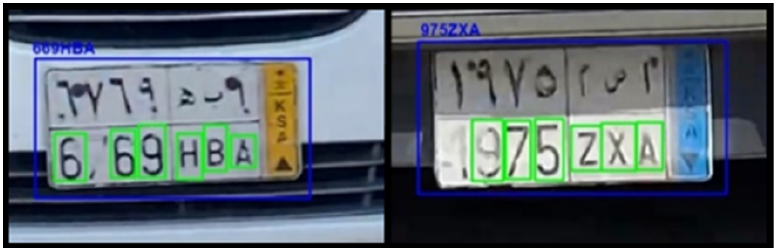
Figure 17. Completely deteriorated alphanumeric and respective recognition results.